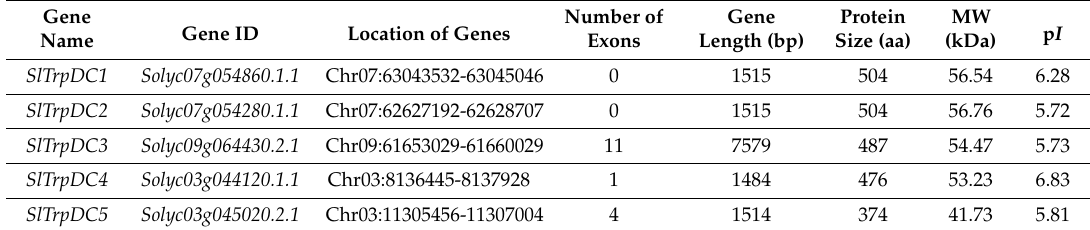
Table 1. The SlTrpCD genes in